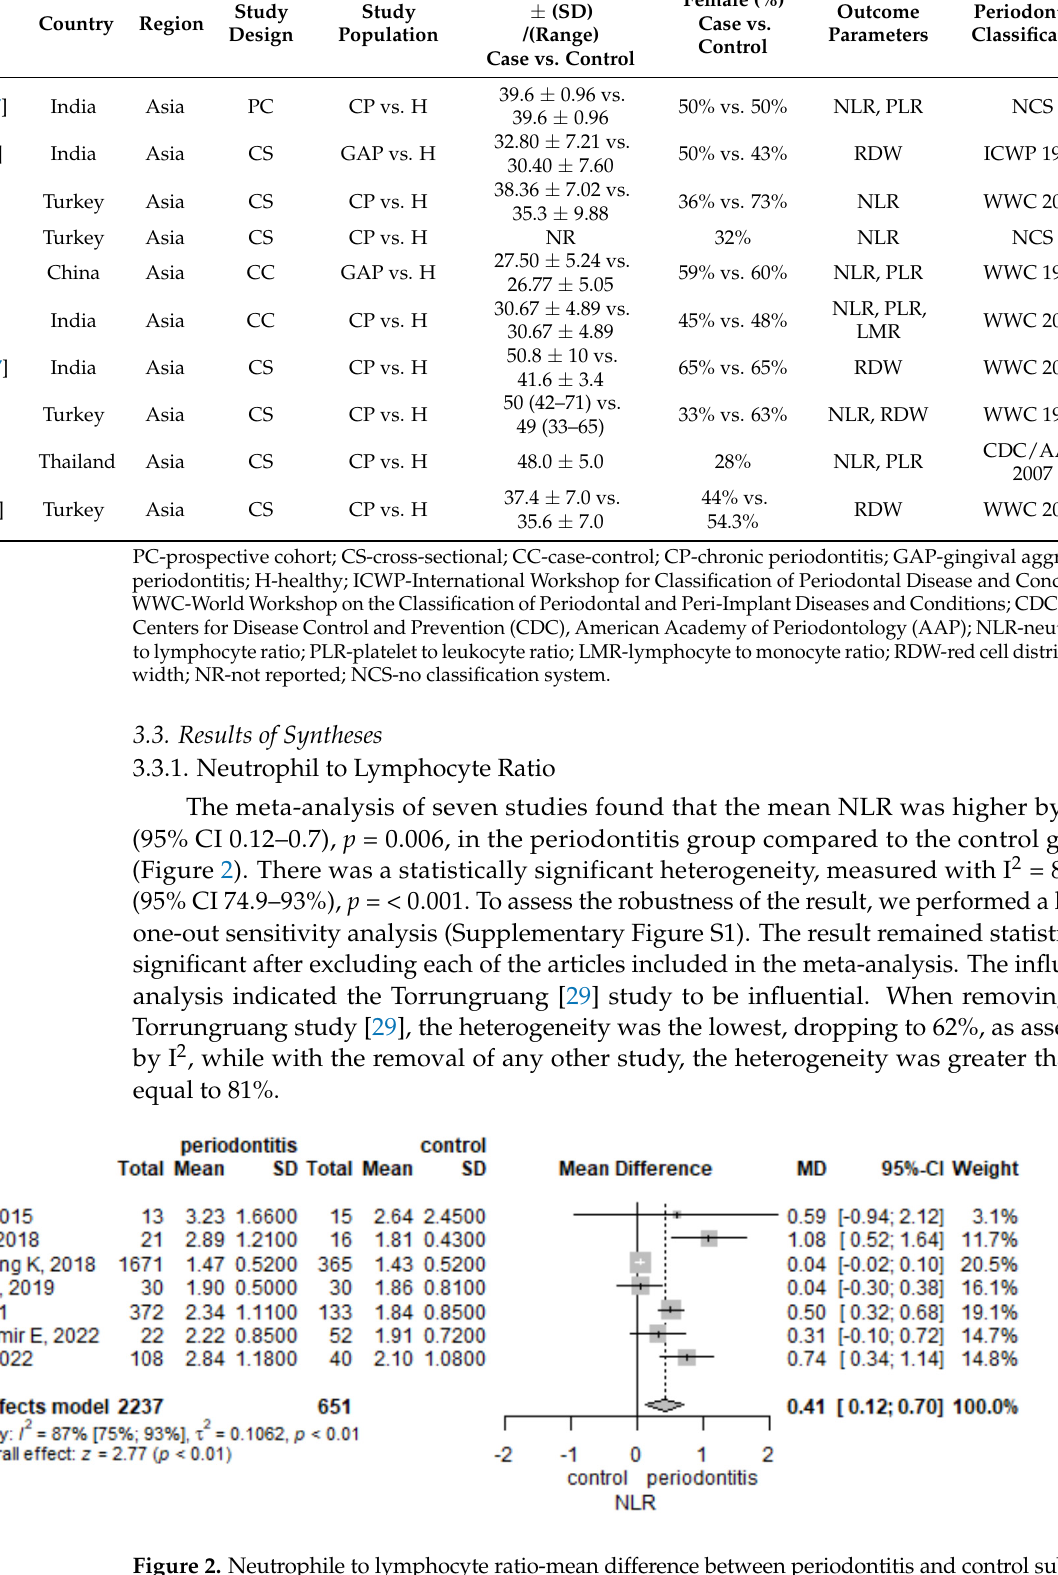
Figure 2. Neutrophile to lymphocyte ratio-mean difference between periodontitis and control